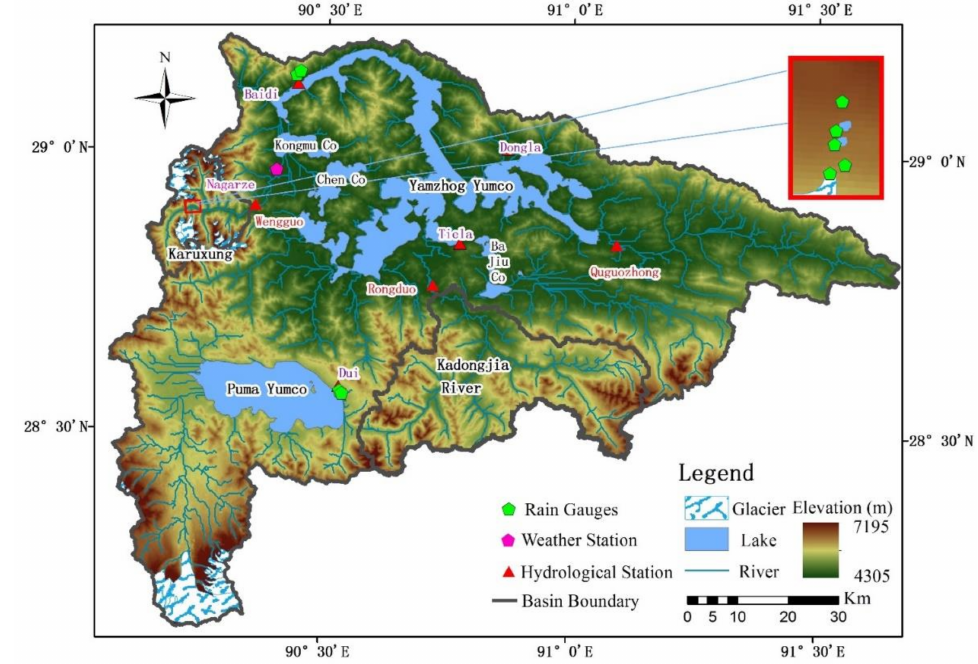
Figure 1. The Yamzho Yumco Lake